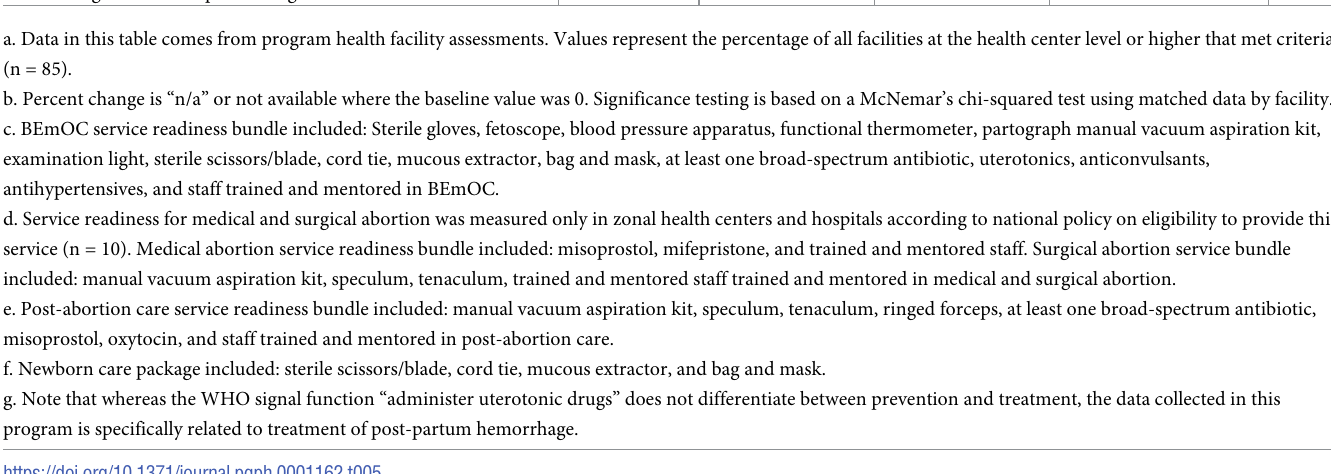
parenteral anticonvulsants for the management of pre-eclampsia/eclampsia (from 20.0% to 43.5%), removal of retained products of conception (from 44.7% to 84.7%) and assisted vaginal delivery (from 24.7% to 37.7%) in the last 90 days. The percentage of facilities performing basic neonatal resuscitation was high at baseline and remained high; while the provision of uterotonic drugs to treat post-partum hemorrhage was also high at baseline, the percentage of facilities providing this service decreased over the program (from 89.4% to 74.1%). Routine use of uterotonics to prevent post-partum hemorrhage was not captured but may have